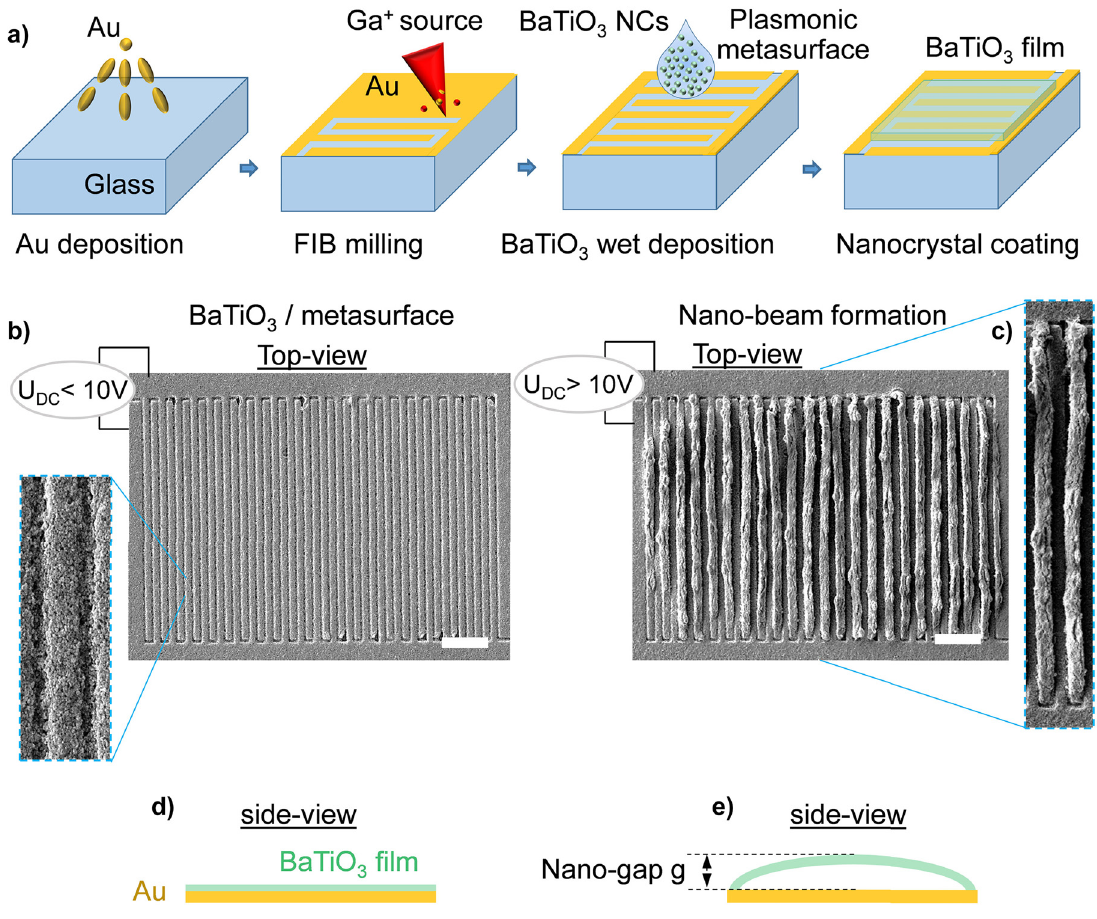
nanobeams. Figure 1: Fabrication steps of the deformable assemblies of BaTiO 3 nanocrystals on top of gold metasurface. A gold film of 200 nm (a) Fabrication procedure of the randomly oriented thin film of BaTiO 3 thickness is deposited on glass by e-beam evaporation and subsequently nanostructured by focused ion beam (FIB) milling. Next, we use nanocrystals (average diameter 50 nm) in water solution and deposit them by drop-cast/spin-coating, producing a BaTiO suspended BaTiO 3 3 film on top of the plasmonic metasurface. (b) Top-down SEM image of the plasmonic-ferroelectric nanostructure; samples remain intact for bias voltage lower than 10 V, scale bar 3 μ m. The SEM inset shows a section of the sample under higher magnification. (c) Top-down SEM image of the plasmonic-ferroelectric nanostructure after the application of 10 V; SEM shows the mechanical buckling of the BaTiO 3 nanocrystals actuated from the high potential gold nanowires, scale bar 3 μ m. The SEM inset shows a pair of buckled nanobeams. (d and e) Side view schematic before and after the nanobeam formation, with the corresponding nanogap annotated as g